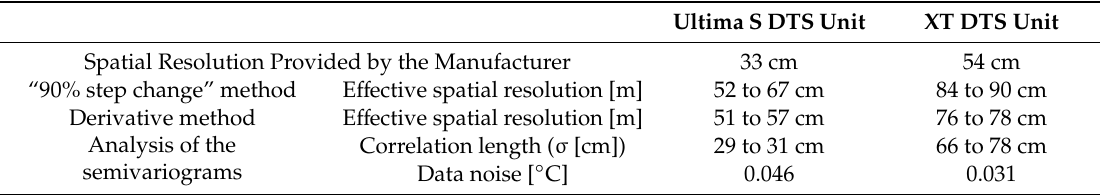
Table 1. Comparison of e ff ective spatial resolutions estimated from the di ff erent methods for both DTS units. Ultima S DTS Unit XT DTS Unit Spatial Resolution Provided by the Manufacturer 33 cm 54